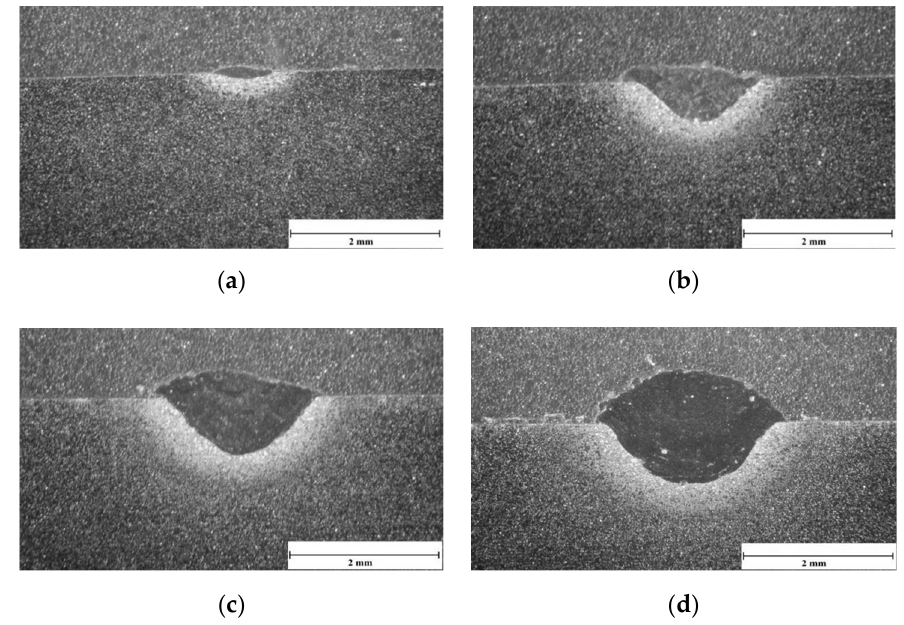
Figure 5. Macrostructure and the single bead geometry of the clad layers produced by laser cladding of Fe-based powder on steel substrate at free cooling, constant scanning speed 250 mm/min, and different laser output power, Tables 3 and 4: ( a ) LC1, 250 W; ( b ) LC2, 500 W; ( c ) LC3, 750 W; ( d ) LC4, 1000 W.